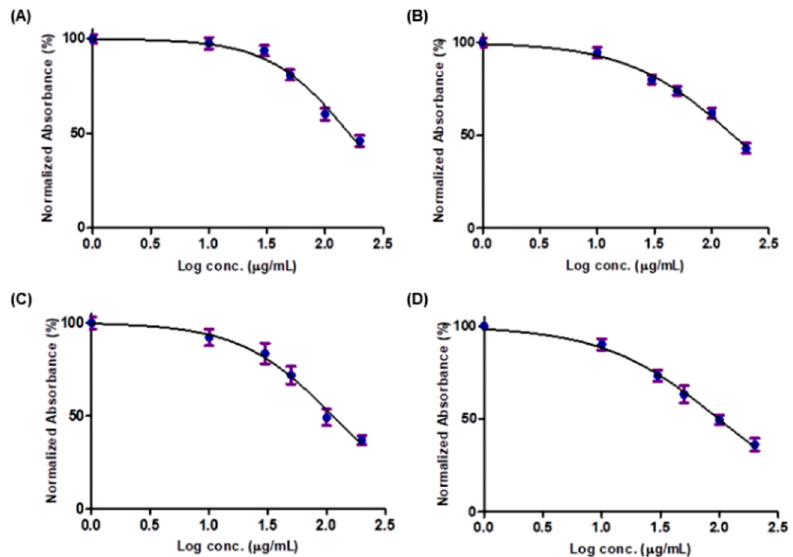
Figure 2. SRB assay on HEK293 cells to evaluate the effect of the four plant extracts: ( A ) XA, ( B ) IC, ( C ) EG and ( D ) DP on the cell growth after 48 h (X-axis: log concentrations of extracts from 1 to 200 (µg/mL) and Y-axis: the percentage of normalized absorbance). Values are mean ± SD of three independent experiments.